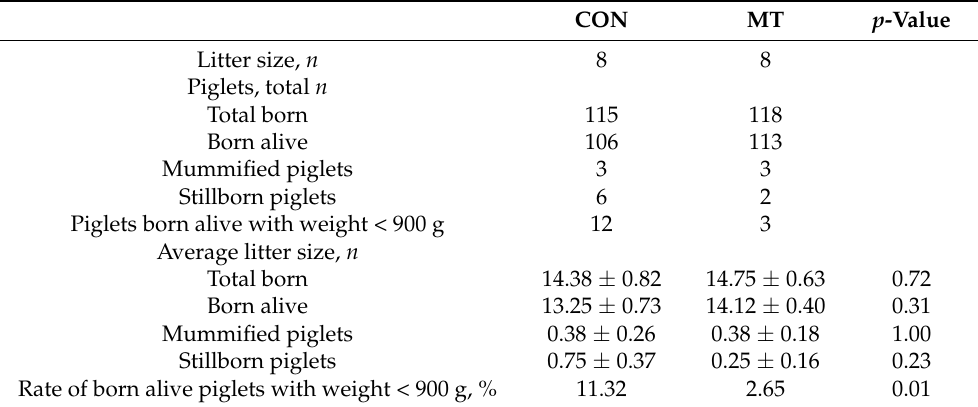
Table 1. Effects of maternal MT supplementation during gestation on the reproductive performance of